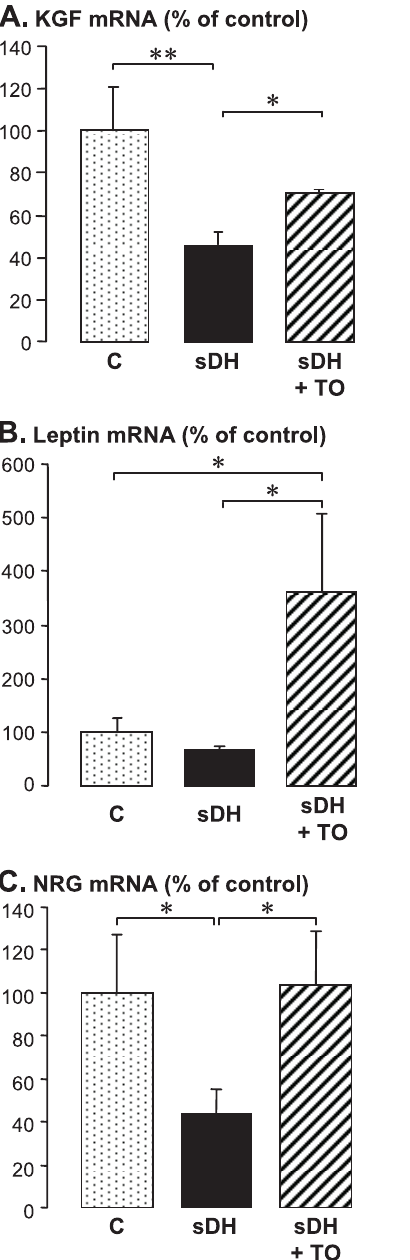
Figure 6. KGF, Leptin, and NRG mRNAs in Ovine Fetal Lungs RT followed by real-time PCR analysis; mean 6 standard error of the mean on six, five, and three individual samples, respectively, in sham- operated control fetuses (C), in a surgical model of CDH (sDH), and in sDH with subsequent tracheal occlusion (sDH þ TO). The Kruskal-Wallis test was used for multiple-group comparison, with two-group compar- isons made by Mann-Whitney U-test (* p , 0.05 and ** p , 0.01). (A) KGF mRNA level was reduced by half by sDH and was partially restored by sDH þ TO. (B) Leptin mRNA was not affected by sDH, whereas TO enhanced expression to 3.5 times the control level. (C) NRG mRNA level was decreased by 60% by sDH and was restored by sDH þ